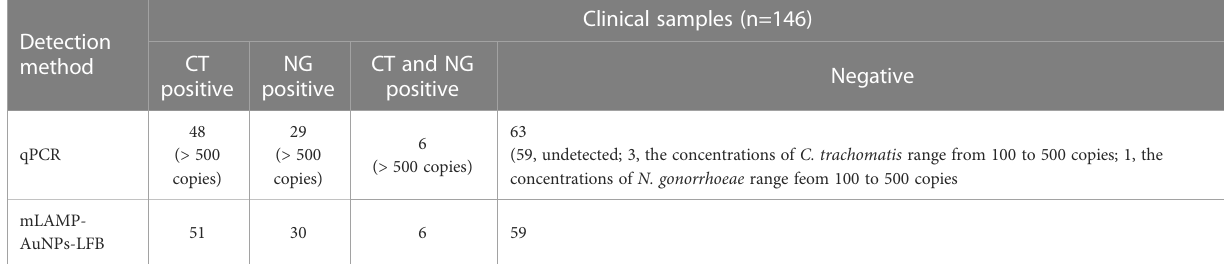
TABLE 3 Comparing C. trachomatis and N. gonorrhoeae levels in clinical samples using our mLAMP-AuNPs-LFB assay and qPCR